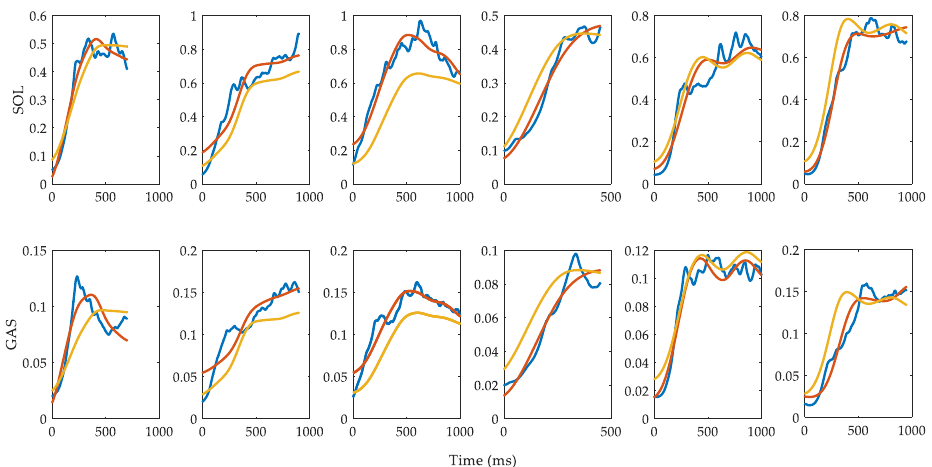
Figure 10. Reflex model fitting results of the forepart of subject A of the six trials. The blue lines are the muscle activation calculated from the measured sEMG signals. The red lines are the prediction results using individually calibrated reflex gains. The yellow lines are the prediction results using mean reflex gains.